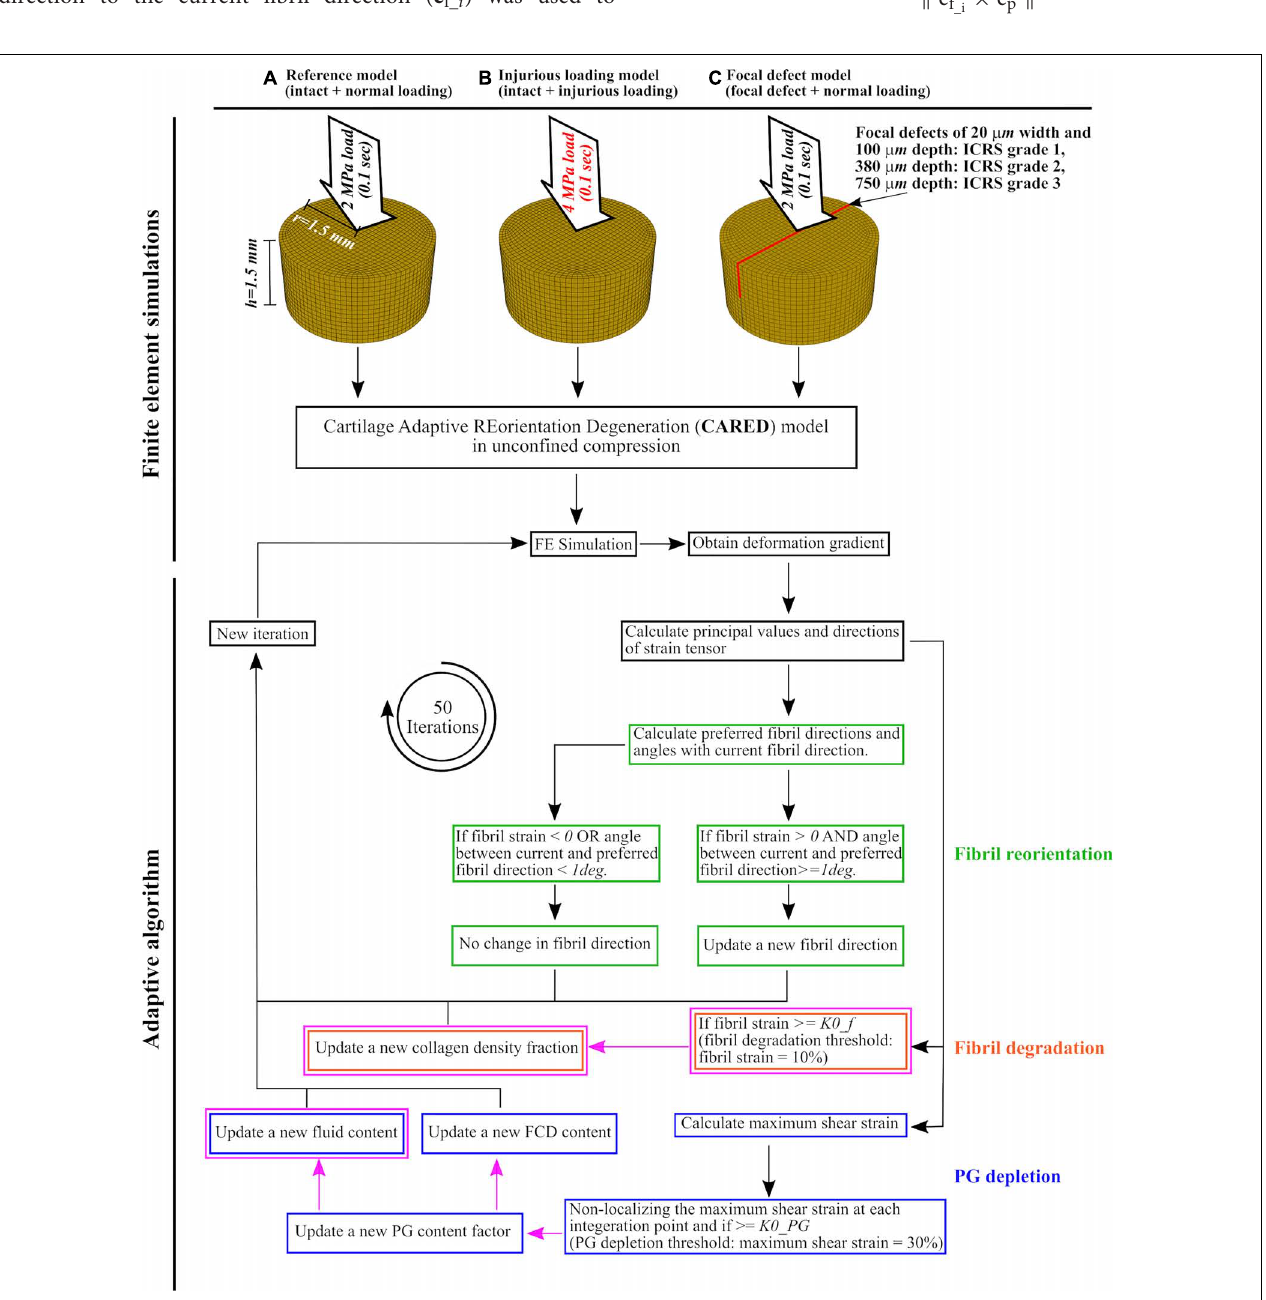
FIGURE 2 | Cartilage explant geometries and applied loadings for the finite element model and the adaptive algorithm: (A) the reference model, (B) the injurious loading model, and (C) the focal defect models of ICRS grades 1, 2, and 3. After finite element simulation, the obtained deformation gradient was used to calculate principal values and directions of strain tensor at each element. These values were used to calculate the fibril reorientation [green frames, adopted from Tanska et al. (2018)], fibril degradation [orange frames, adopted from the studies on arterial tissue (Valentín et al., 2013; Famaey et al., 2018) and changed for cartilage] and PG depletion [blue frames, partially adopted from Eskelinen et al. (2019) and Quiroga et al. (2017)]. The magenta frames and arrows highlight the novelties in (i) adapting the collagen degeneration theory from arterial tissue to cartilage, (ii) using a non-localization theory for PG depletion, (iii) introducing a new algorithm for the increase in tissue hydration, and (iv) relating hydration variations and FCD loss to PG depletion. The definitions of preferred fibril directions and the angle between current and preferred fibril direction can be found in section “Collagen Fibril Reorientation Algorithm”.